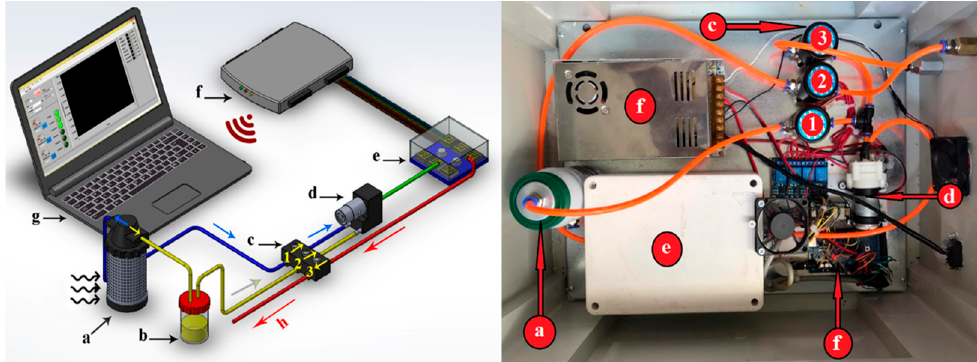
Figure 1. Schematic and photograph of an artificial olfactory (e-nose) system, arranged in tandem, for introduction of essential oil VOCs, used for gas-sample analysis. The components of this system consist of the following parts (listed in order and direction of air flow as follows). Ambient air first enters ( a ) air filter (activated charcoal to remove ambient-air VOC hydrocarbons), then yellow line to ( b ) sample headspace chamber, and ( c ) solenoid air valves ( 1 – 3 ), then ( d ) diaphragm pump, (green line) to ( e ) e-nose sensor array chamber, ( f ) data acquisition recorder and wireless transmission card, ( g ) personal computer (PC) and ( h ), air outlet (red line) from sensor array chamber (for exhaust gases). Filtered air from air filter (blue line) alternatively passes to the e-nose sensor array chamber (via Solenoid air valve) during air-cleanse purges between samples.